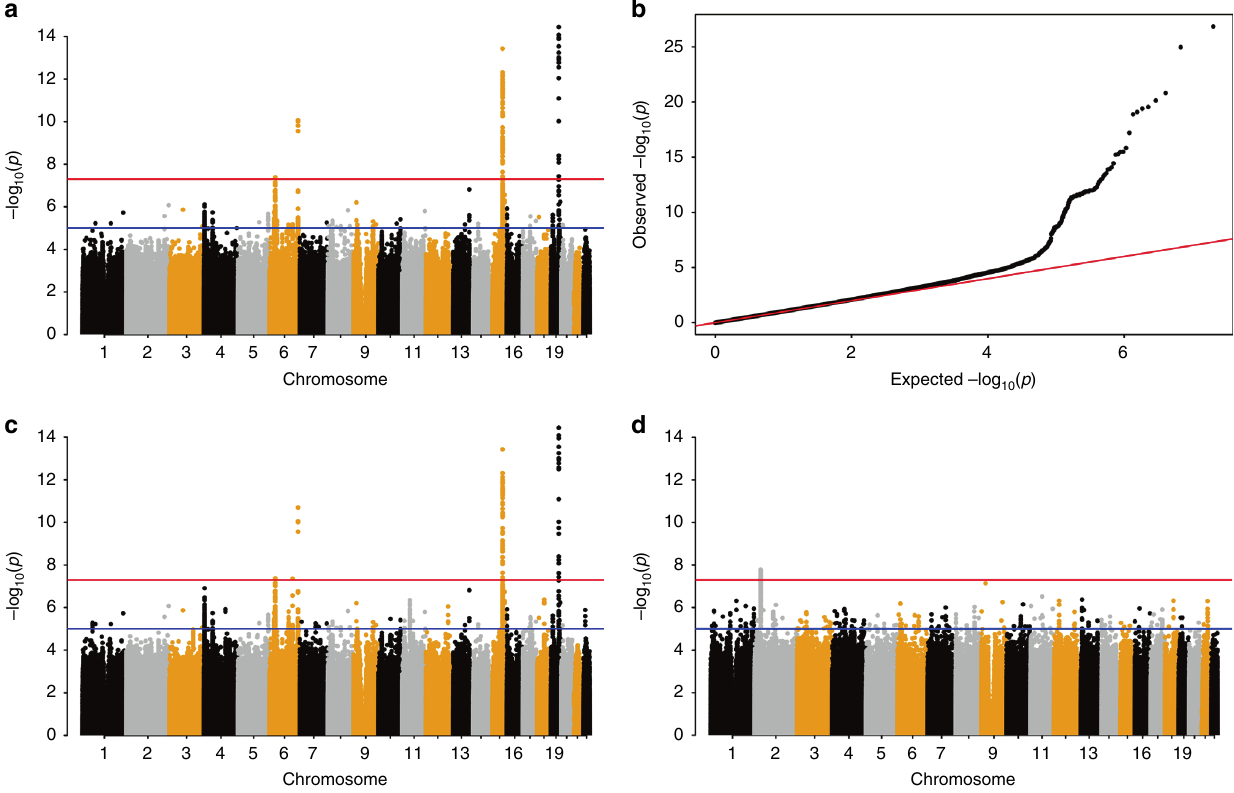
Fig. 1 Genome-wide associations with parental lifespan. Association analysis was carried out using imputed allelic dosages. a Manhattan plot for LifeGen European ancestry, with both parents combined; b Q − Q plot comparing the expected (under the null hypothesis) and actual (observed) – log 10 p -values for results in a ; c Manhattan plot of meta-analysis of LifeGen Europeans (both parents combined) with CHARGE-EU 90+ published summary statistics 6 . The meta-analysis used Z -scores and equal weights, as suggested by the near equality (9.5/9.4, LifeGen, CHARGE) of Z -test statistics at rs4420638. The additional (just) GW signi fi cant SNP lies between the two chromosome 6 hits in a ; d Manhattan plot for LifeGen African fathers only. In Manhattan plots, the y -axis has been restricted to 15 to aid